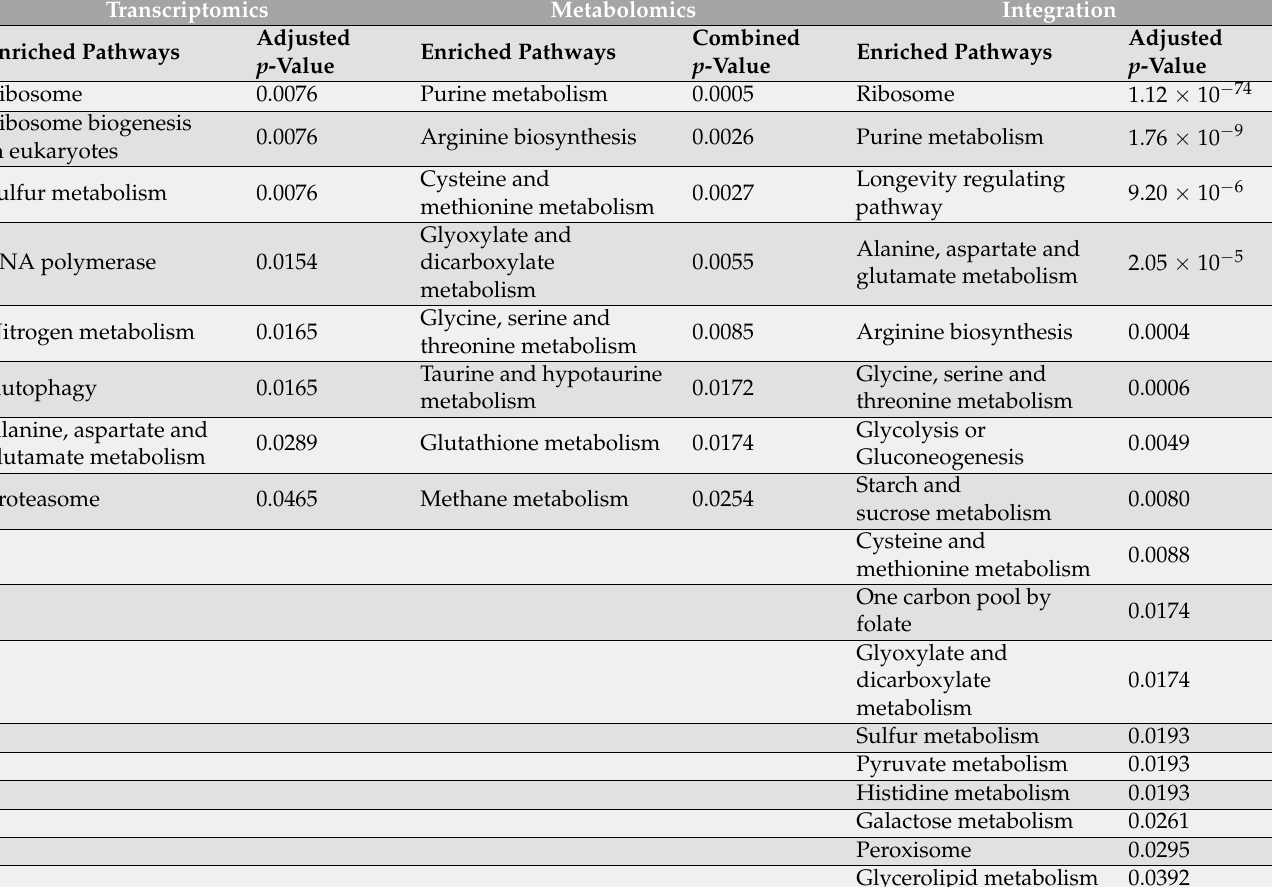
Table 2. Single- and multi-omics integration results for snf3 ∆ rgt2 ∆ . First block shows GSEA for transcriptomics with adjusted p -value < 0.05, arranged in ascending order; second block shows MetaboAnalystR pathway enrichment analysis for metabolomics with combined p -value < 0.05, arranged in ascending order; third block shows MetaboAnalystR joint pathway analysis with adjusted p -value < 0.05, arranged in ascending order, as detailed in the